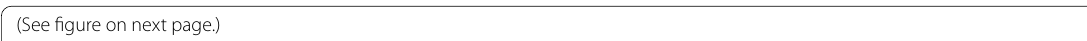
Flu) ( b ). c Observation of sclerotium production + =